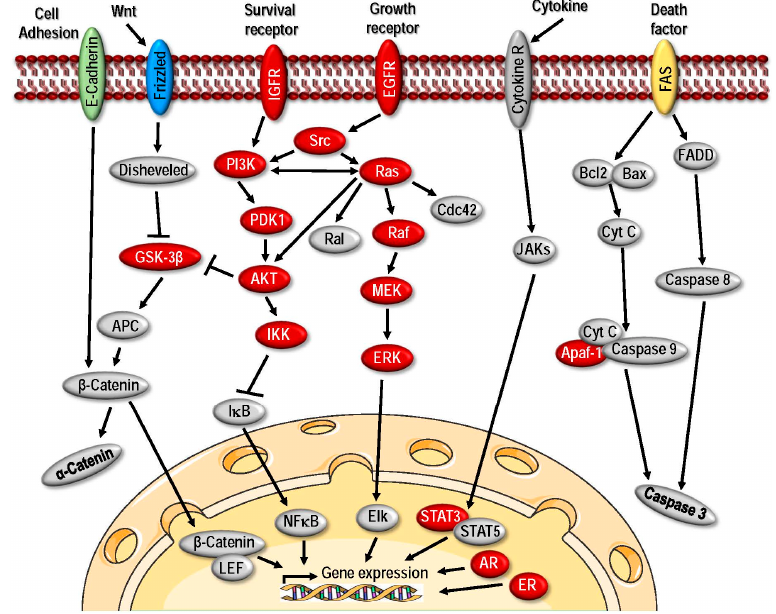
Figure 4. HSP90 regulation of key oncoproteins promotes tumor progression. HSP90 clientele consists of many oncogenic signal transduction proteins (red) that rely upon HSP90 chaperonage for their maturation and stabilization. Examples of these proteins include steroid receptor family members, receptor tyrosine kinases, Src family members, serine-threonine kinases, telomerase, cell cycle regulators that are essential member of many of the key signaling pathways involved in cancer progression. HSP90 clients also contribute to all six “hallmarks of cancer” [26,105] including evasion of apoptosis (e.g., Apaf-1, p53, protein kinase B (PKB), also known as Akt, Survivin), self-sufficiency in growth signaling (e.g., epidermal growth factor receptor or EGFR/human epidermal growth factor receptor 2 or HER2, Src, rapidly accelerated fibrosarcoma or RAF, MAPK/ERK Kinase or MEK etc.), insensitivity to anti-growth signals (e.g., cyclin-dependent kinase 4 or Cdk4, Myt1, Wee1, etc.), tissue invasion and metastasis (e.g., hepatocyte growth factor receptor or c-MET), sustained angiogenesis (e.g., vascular endothelial growth factor or VEGFR, Fit-3, Akt, etc.), and limitless replicative potential (e.g., hTert) [106].